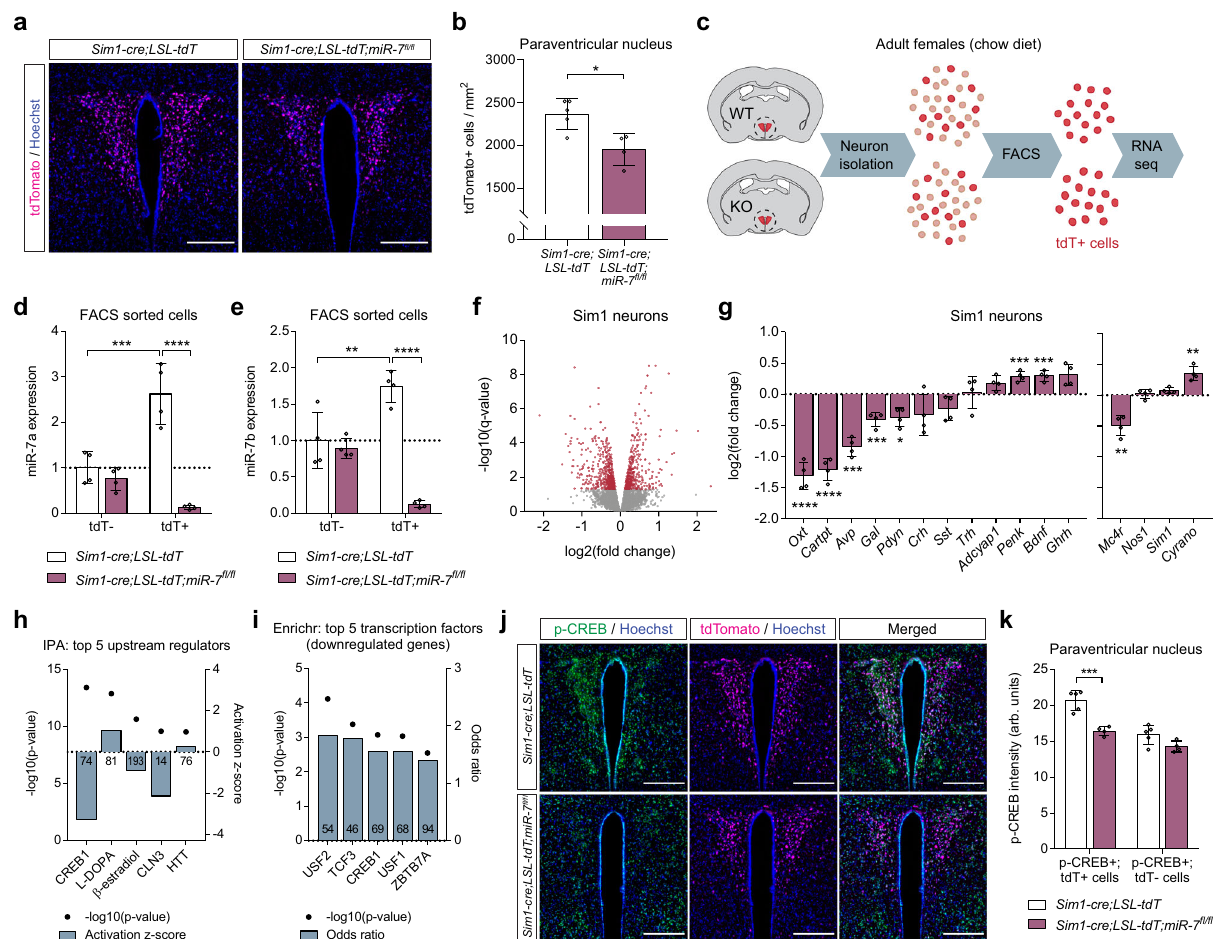
Fig. 4 | Cellular dysfunction of Sim1 neurons upon mir-7 ablation. a – b Repre- sentative image (scale bar: 250 μ m) ( a ) and quanti fi cation ( n =5 and 4 animals) ( b ) of tdTomato-positive cells within the PVN of Sim1-cre;LSL-tdTomato and Sim1- cre;LSL-tdTomato;mir-7 fl / fl mice. Magenta,tdTomato; blue, Hoechst. c Schematic of sample preparation for RNA sequencing of Sim1 neurons from Sim1-cre;LSL-tdTo- mato ( “ WT ” ) and Sim1-cre;LSL-tdTomato;mir-7 fl / fl ( “ KO ” ) mice. d – e miR-7a ( d ) and miR-7b ( e ) expression in tdTomato-negative and tdTomato-positive FACS-sorted cells from hypothalamus of Sim1-cre;LSL-tdTomato and Sim1-cre;LSL-tdTomato;mir- 7 fl / fl mice ( n =4 samples, with 4 mice pooled per sample). Expression is relative to tdT-negative cells from Sim1-cre;LSL-tdTomato mice. f – log10( q -value) and log2(- fold change) of all expressed genes in Sim1-cre;LSL-tdTomato;mir-7 fl / fl versus Sim1- cre;LSL-tdTomato RNAsequencingdata.Signi fi cantlyregulatedgenes( q <0.05)are indicated in red. g log2(fold change) of key neuropeptide-encoding genes (left panel),and Mc4r , Nos1 , Sim1 ,and Cyrano (rightpanel)in Sim1-cre;LSL-tdTomato;mir- 7 fl / fl versus Sim1-cre;LSL-tdTomato RNAsequencingdata( n =4samples,with4mice pooled per sample). h – log10(p-value) and activation z-scores of top upstream